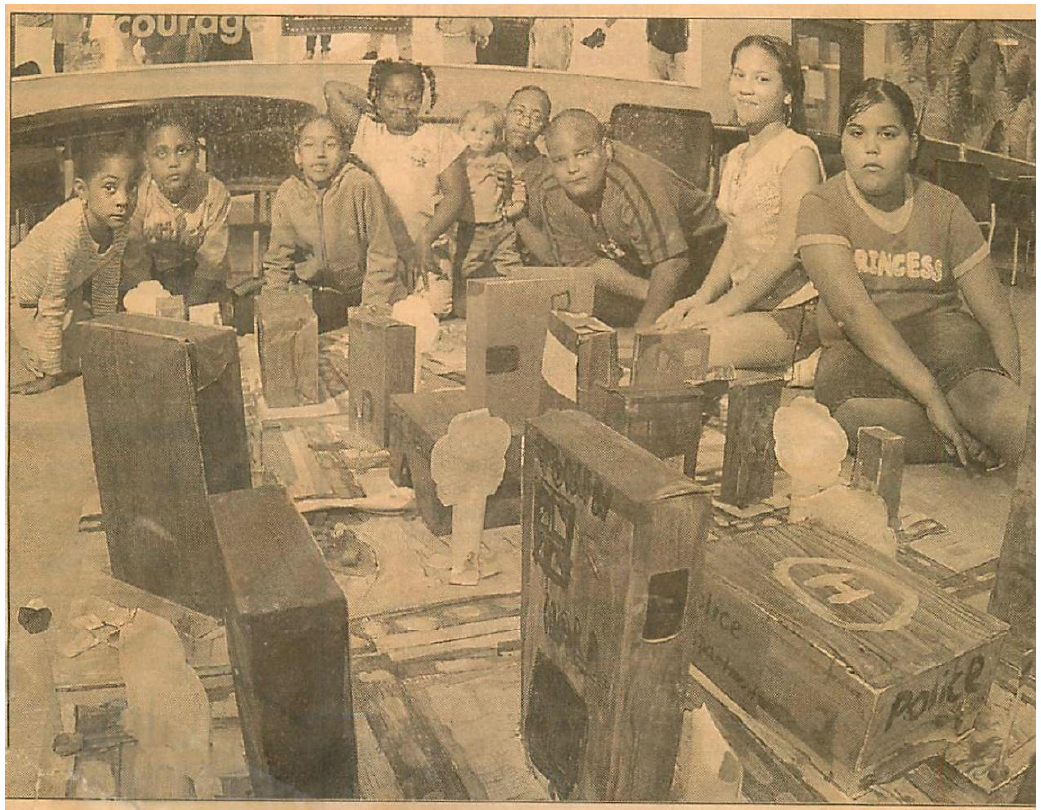
Figure 1. Photo from Connecticut Post article, 1 June 2003. (Abraham 2003)